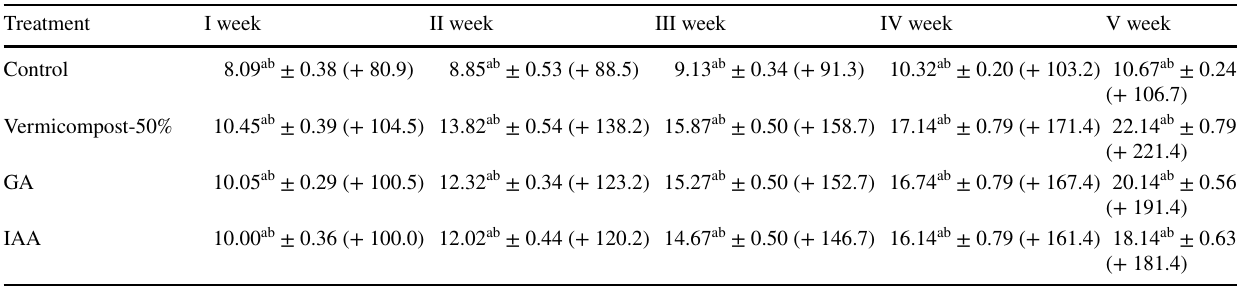
Table 2 Effect of vermicompost and PGRs on the shoot length (cms) of C. annum